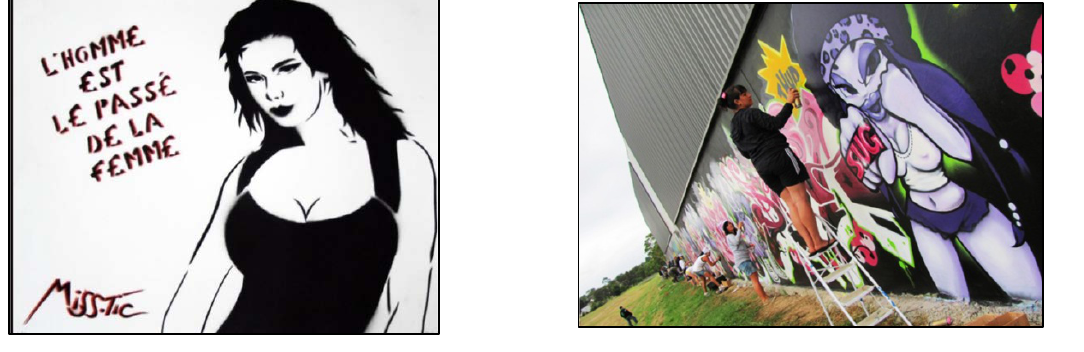
Figure3. A "Stick Up Girlz" mural, Australia